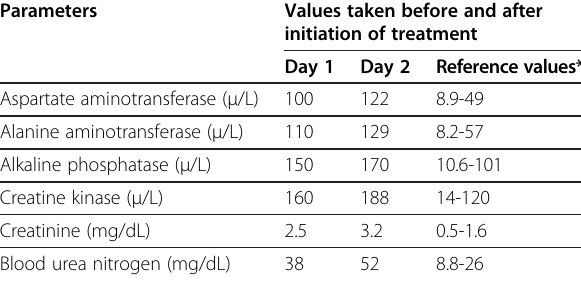
Table 2 Serum biochemistry values of a female German shepherd dog attacked by